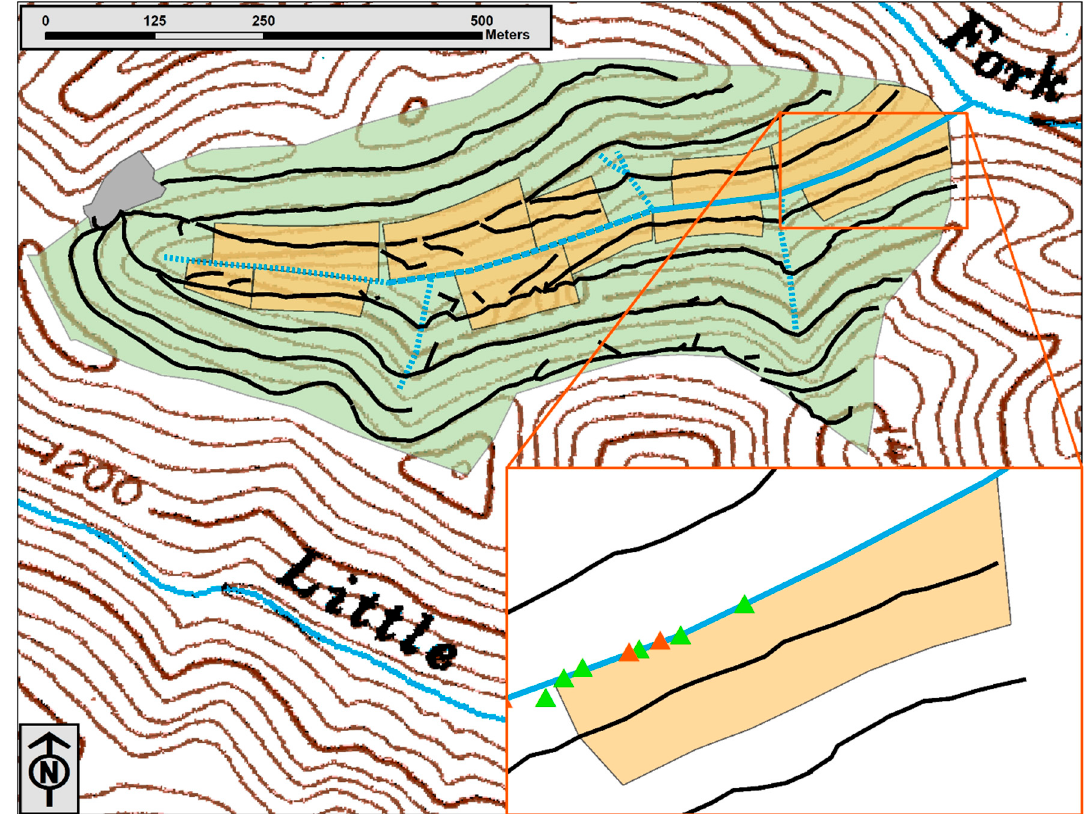
Figure 1. Map of the treatment 2 watershed (green) indicating experimental units (tan), perennial (solid blue) and intermittent streams (bold dashed blue), ephemeral channels (hatched blue), constructed skid trails (black lines) and log landing (grey). Inset of one of the experimental units shows triangles denoting the location of sediment paths entering the stream (green from north facing slope, red from south facing slope.).